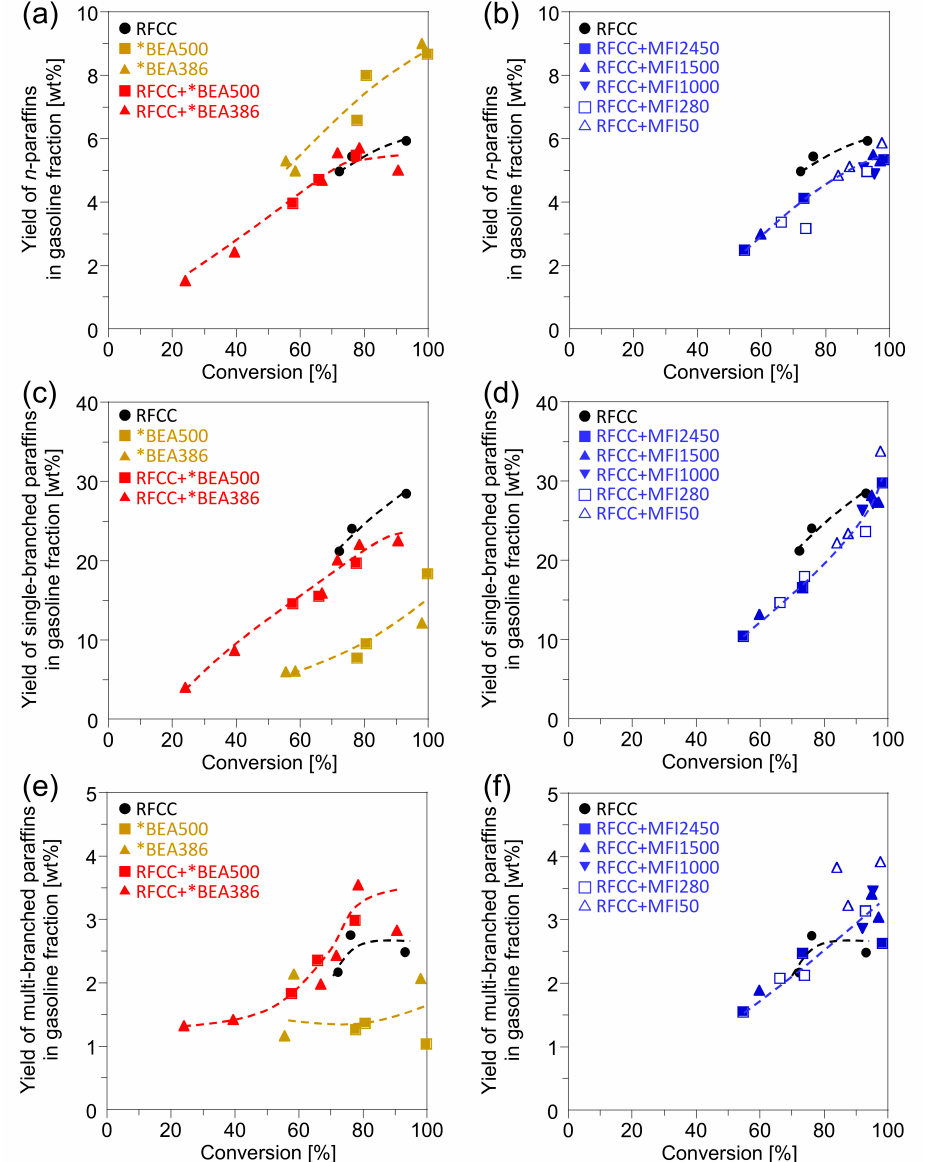
Figure 5. Yields of the paraffin products in the gasoline fraction. ( a )( b ) Linear paraffin yield. ( c )( d ) Single-branched paraffin yield. ( e )( f )Multi-branched paraffin yield. ( a )( c )( e ) Reaction product on the *BEA catalyst and the composite catalyst with the *BEA zeolite. ( b )( d )( f ) Reaction product on the composite catalyst with the MFI